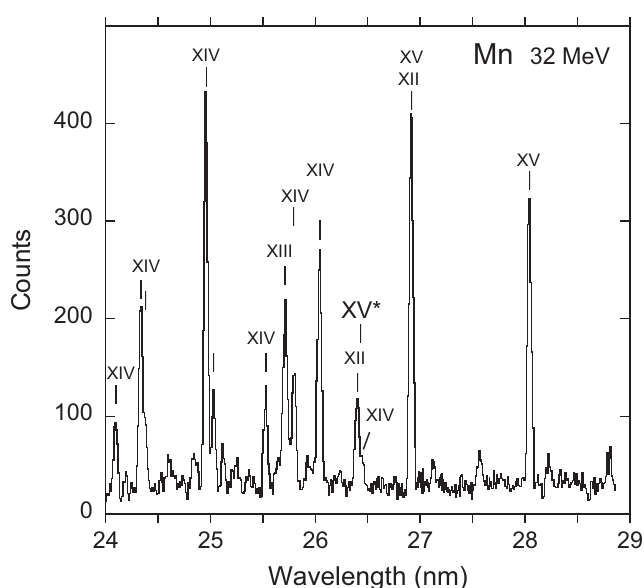
Figure 6. Beam-foil spectrum of 55 Mn recorded at an ion beam energy of 32MeV, near the optimum ion beam energy for the production of the MnXV spectrum [74]: Line width (FWHM) is 0.045nm. The more prominent ones among the lines are labeled by the spectrum number [75]. Near 26.99nm and 28nm lie the prominent and well-known 3p–3d transitions of singly excited MnXV. The shorter-wavelength line of the multiplet suffers from a blend with Mn XI, which affects the reliability of the wavelength determination of this calibration line. The MnXV* line of present interest lies at λ ≈ 26.4nm and is part of a blend with lines of Mn XII and Mn